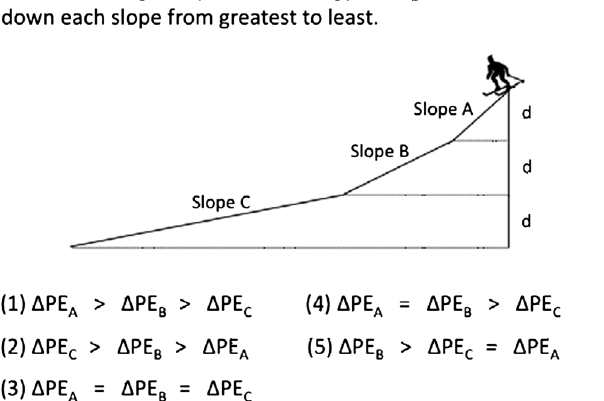
FIG. 10. Problem 10 used in studies 1 and 2.